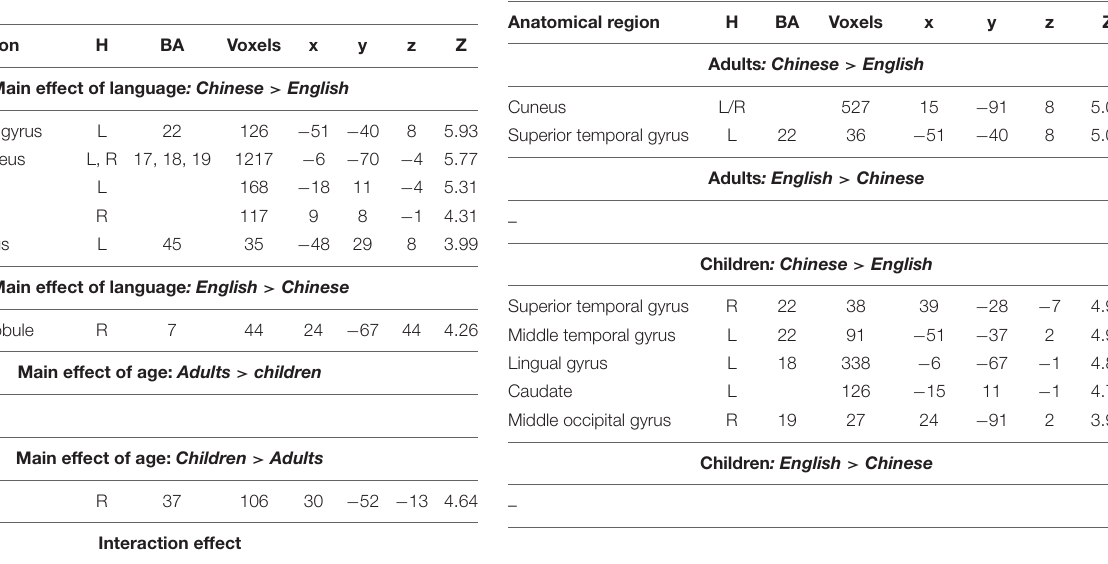
TABLE 3 | Brain regions that showed significant differences between Chinese and English in either adults or children.